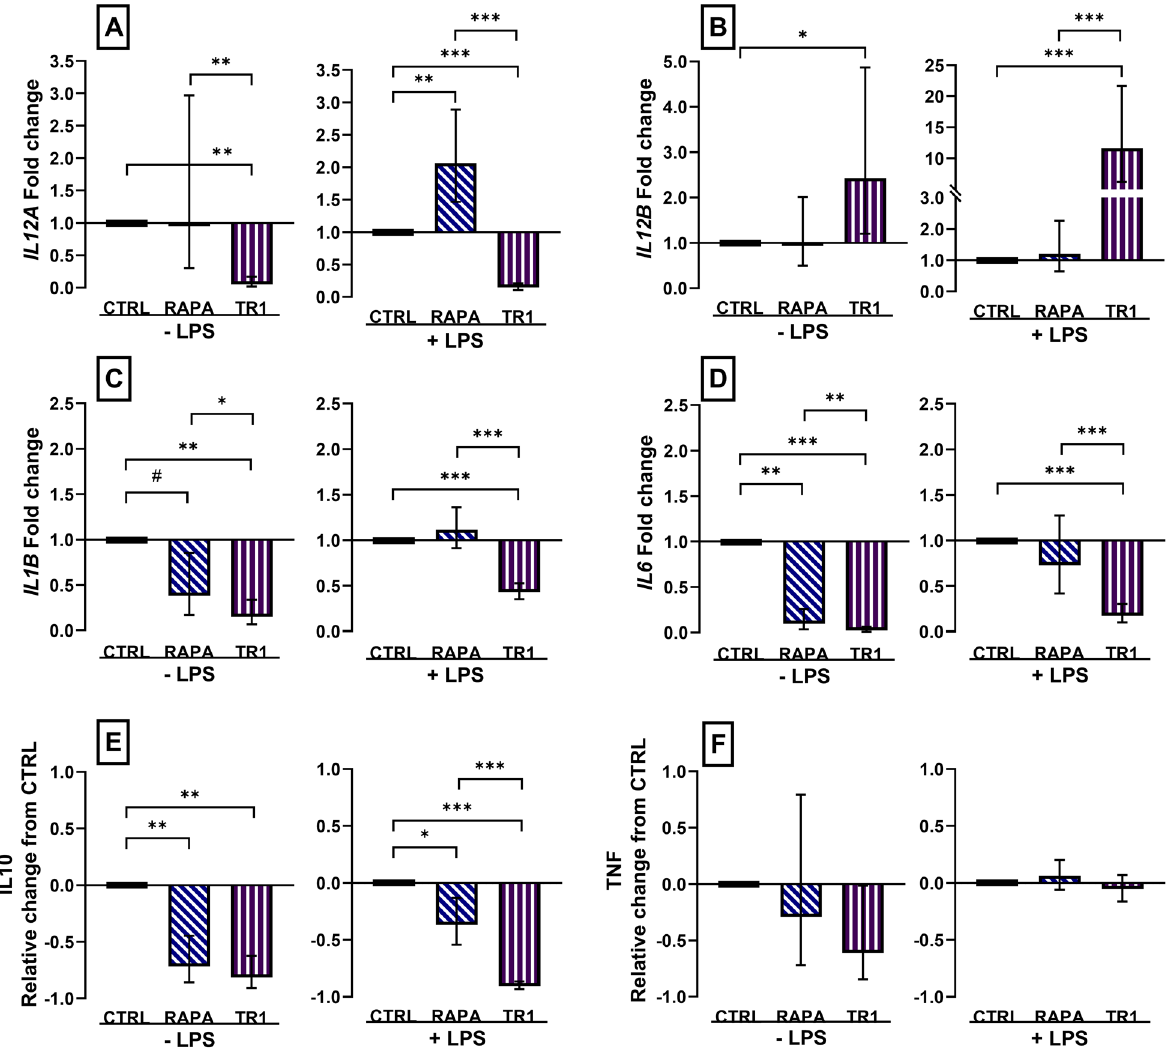
Figure 2. Changes in cytokine mRNA abundance and production in M1 macrophages polarized for 3 days with 10 ng/mL IFNG and 20 ng/mL CSF2 and concurrently treated with vehicle (CTRL), or inhibitors rapamycin (RAPA) or Torin-1 (TR1) at 100 nM. Cells were incubated with vehicle (− LPS) or stimulated with 100 nM LPS (+ LPS) for 4 h to measure changes in mRNA abundance of IL12A , IL12B , IL1B , and IL6 gene expression ( A – D ) or for 16 h to measure production of IL10 and TNF protein ( E , F ). mRNA abundance was expressed as the fold change from CTRL in unstimulated and stimulated cells. Data were expressed relative to CTRL and presented as the relative change from CTRL in unstimulated and stimulated cells for cytokine production. Data from cell isolation of 12 cows are presented as the geometric mean and backtransformed 95% confidence